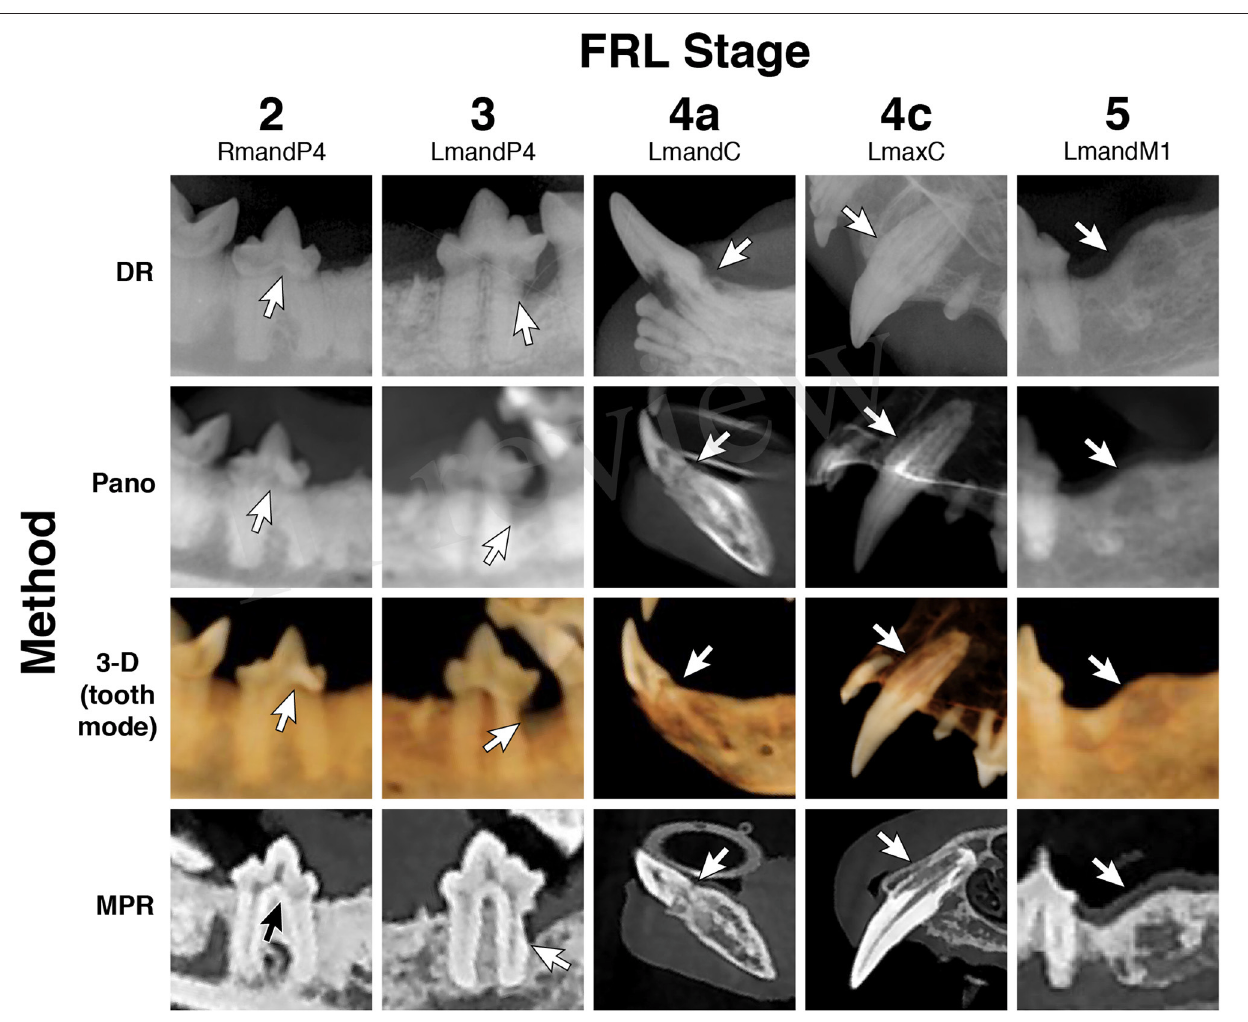
FIGURE 7 | Feline resorptive lesions. Representative images obtained by use of the DR method, Pano method, 3-D method in tooth mode, and custom cross-section MPR method, and used for the evaluation of various radiographic stages of feline resorptive lesions (stages 2, 3, 4a, 4c, and 5). The white arrows indicate the dentoalveolar lesion